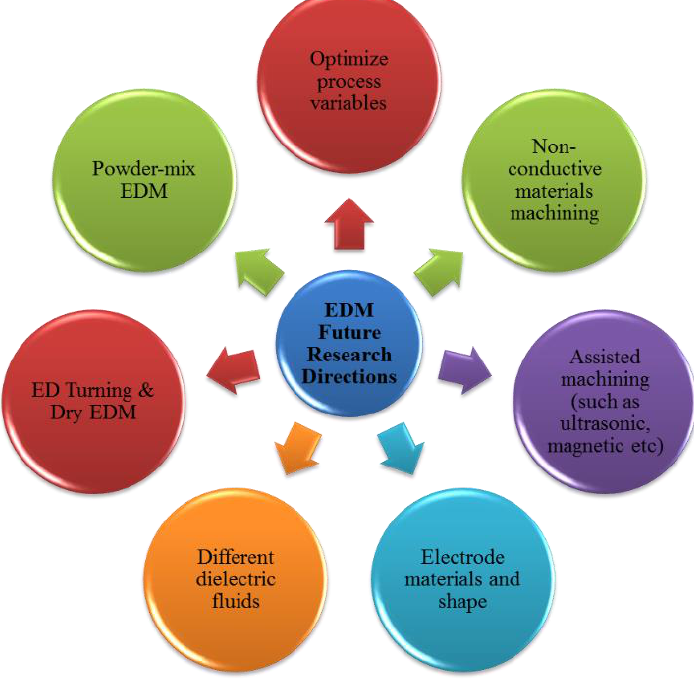
Figure 33. Possible future research areas in EDM.